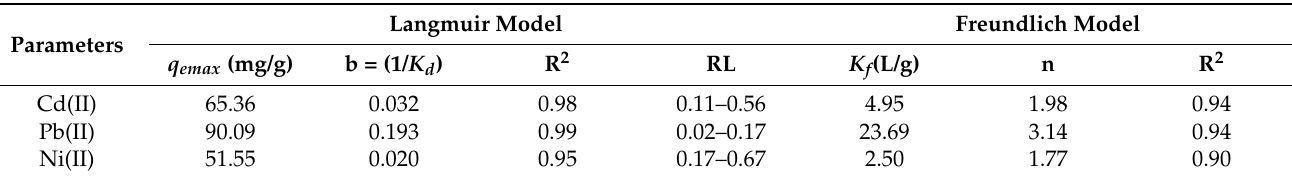
Figure 3. ( A ) Langmuir and ( B ) Freundlich biosorption isotherms of Cd(II), Pb(II), and Ni(II) by S. cerevisiae . Table 2. Isotherm Model Parameters for Adsorption of Cd(II), Pb(II), and Ni(II) on S. cerevisiae using Langmuir and Freundlich